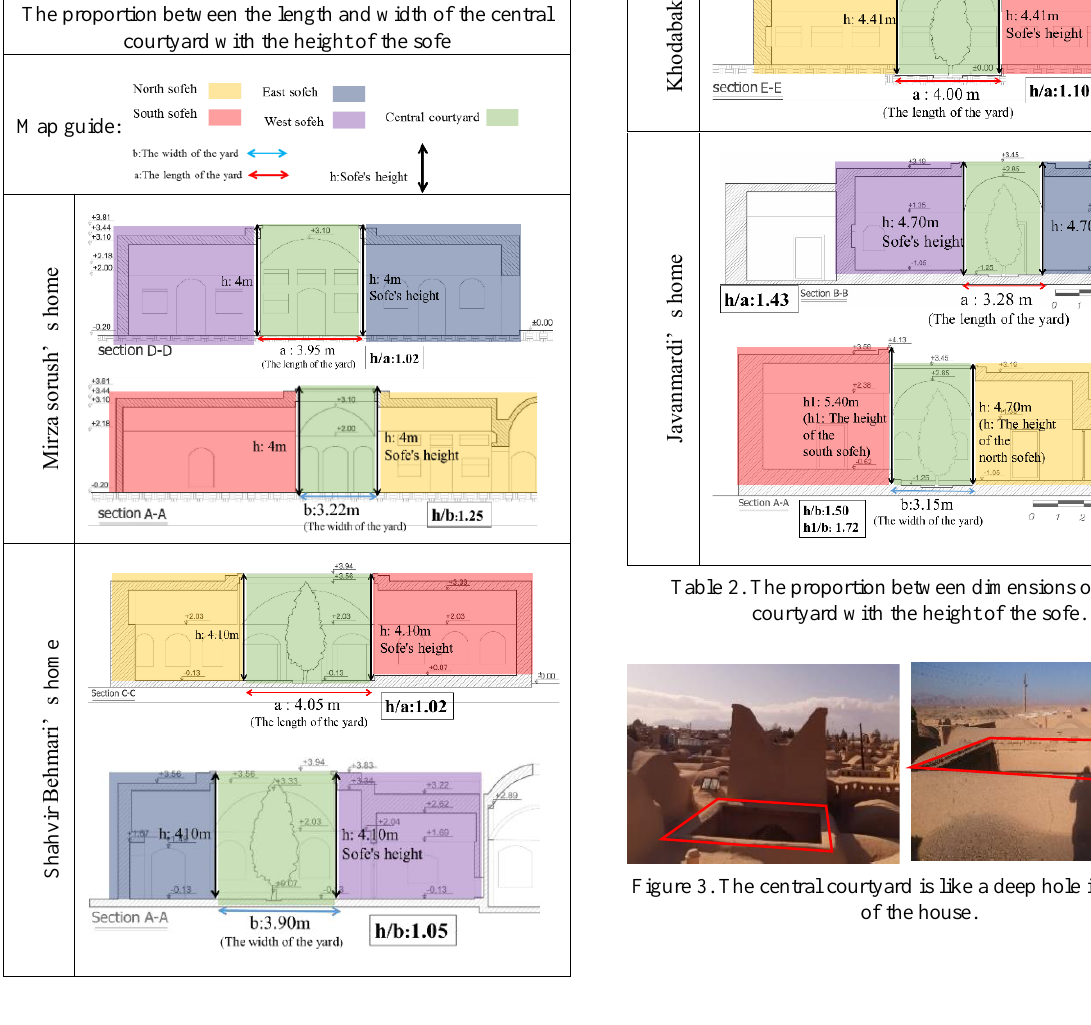
Table 1. Proportion between central courtyard area and whole house. The proportion between the length and width of the central